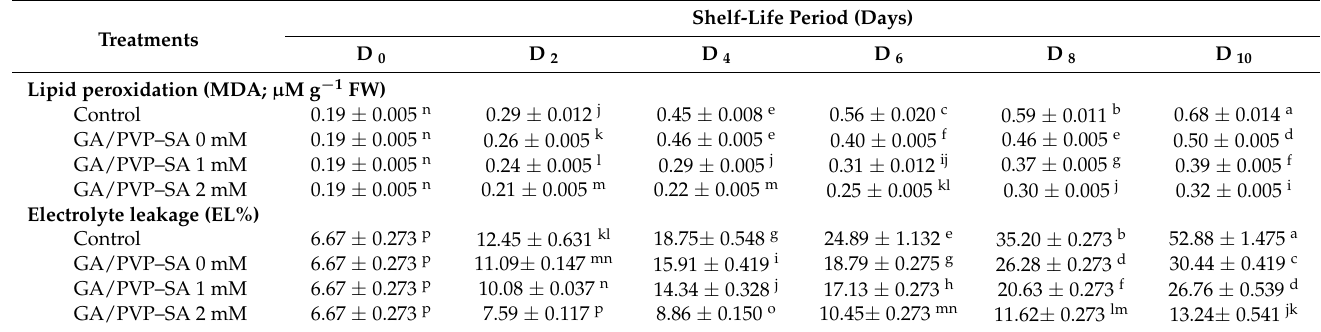
Table 4. Effect of different treatments of gum arabic (GA) and polyvinylpyrrolidone (PVP) blended with salicylic acid (SA) at different concentrations as a mixture biopolymer coating treatment (GA/PVP–SA) on lipid peroxidation (MDA) and cell membrane leakage percentage of peach fruit ‘Early Sweet’ during shelf life at ambient air (29 ± 1 ◦ C and air humidity 51%) during two seasons (2020 and 2021).